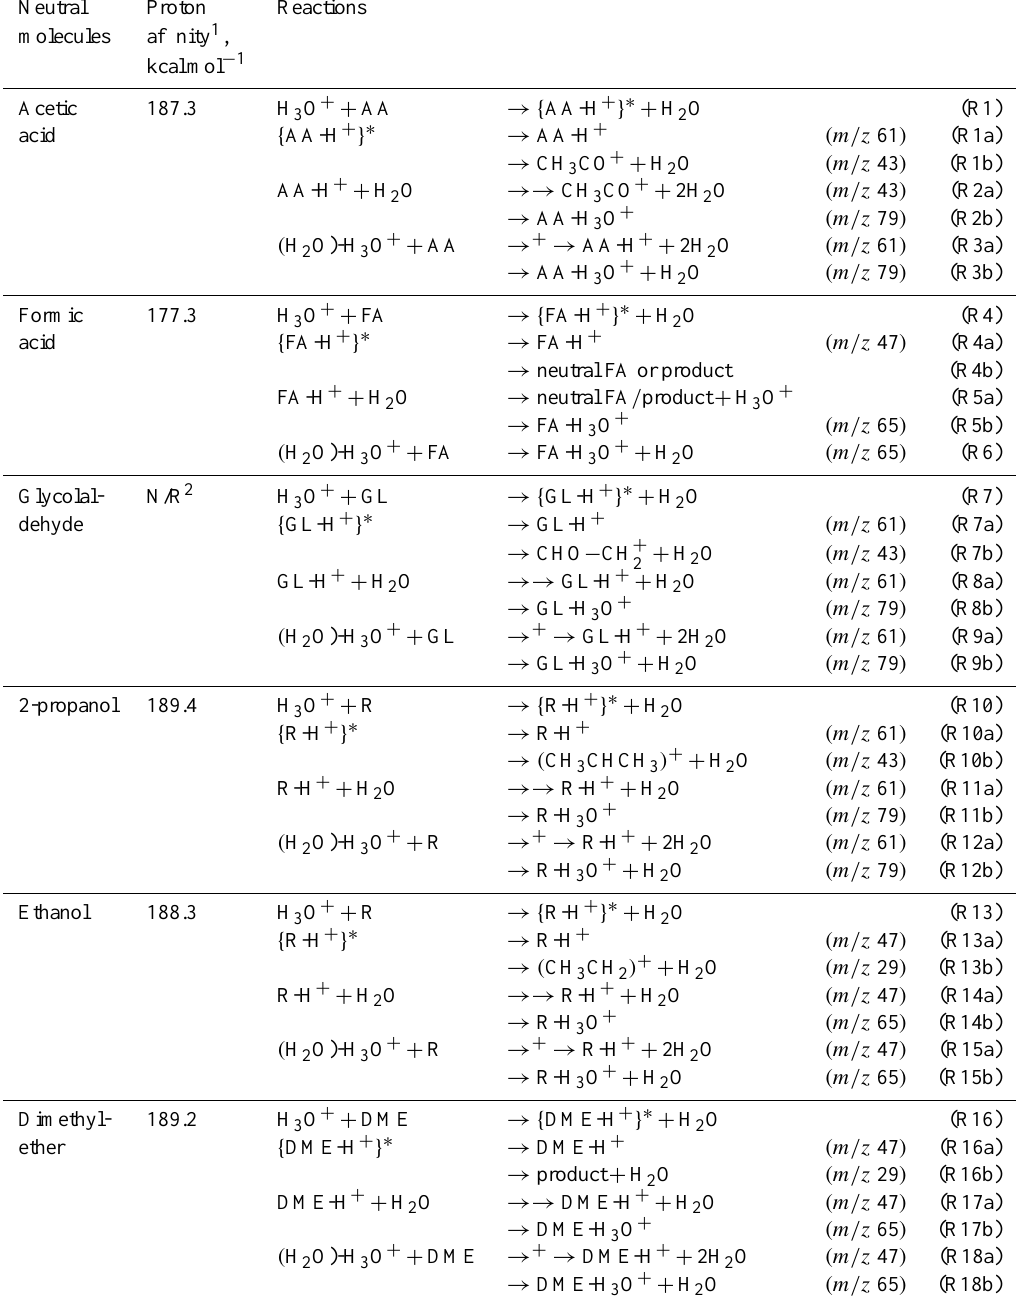
Table 2. Summary of proposed mechanisms taking place in the PTR-MS drift tube accounting for the distribution of product ions originating from AA, FA, and related